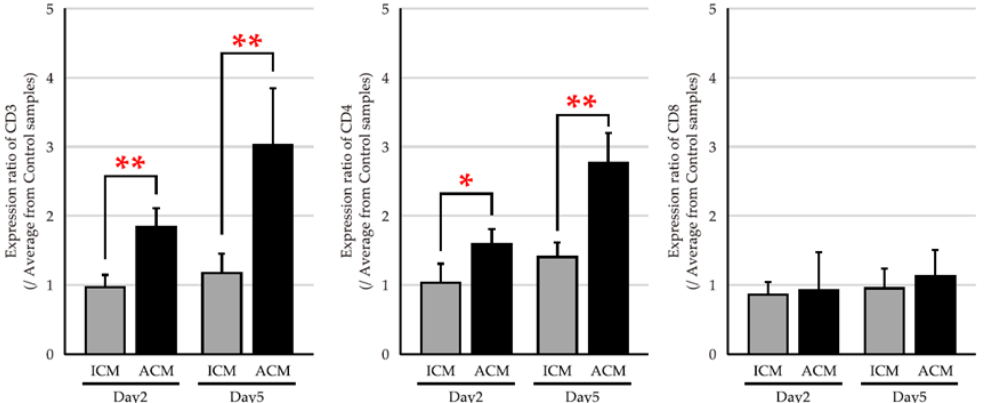
Figure 3. mRNA expression levels of T cell phenotypes in the OM of Pd – induced allergic mice. The mRNA expression levels of CD3, CD4, and CD8 were assessed in the OM of ICM (gray bars) and ACM (black bars) mice ( n = 5) on days 2 and 5 after the challenge. GAPDH gene expression was used as an internal control. Each sample was divided by the average of the control sample to calculate the expression ratio (n = 5). Bars and error bars indicate the mean plus standard deviation. Statistical significance was tested by the Mann–Whitney U test (* p < 0.05, ** p <